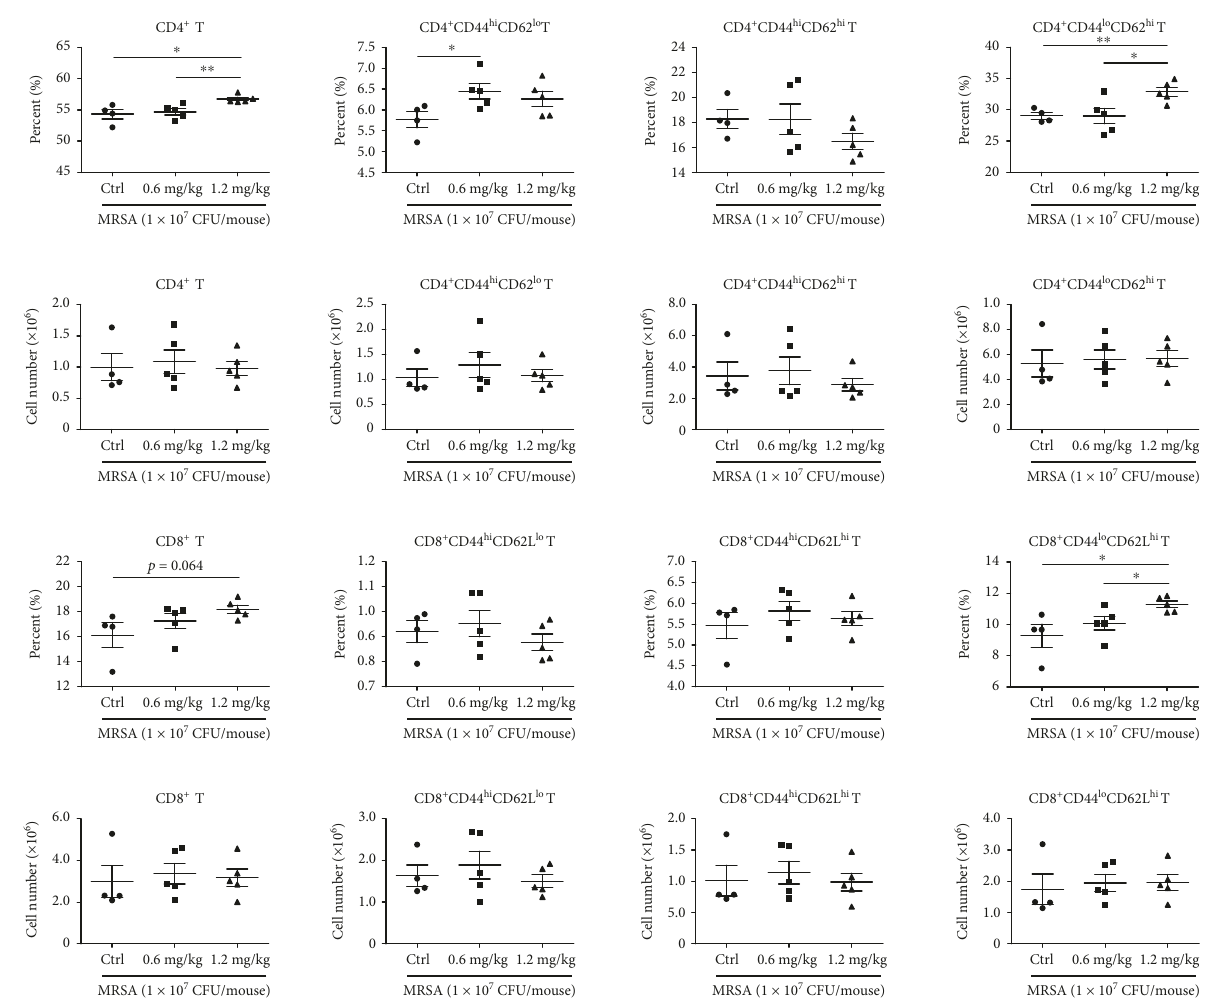
Figure 8: The alteration of various immune cell percentages and cell numbers in the MLNs of MRSA-challenged mice. Mice were orally administered with sublancin (0.6 mg/kg or 1.2mg/kg) for 14 consecutive days before infection. Phenotypic analysis of single-cell suspensions collected from the MLNs (the MLNs were excised from the mice 36 hours after infection). The phenotype of CD4 + and CD8 + T cells was further characterized by the expression of CD44 and CD62L, cell surface receptors which are di ff erentially expressed on activated (CD44 hi CD62L lo ), memory (CD44 hi CD62L hi ), and naïve (CD44 lo CD62L hi ) T cell